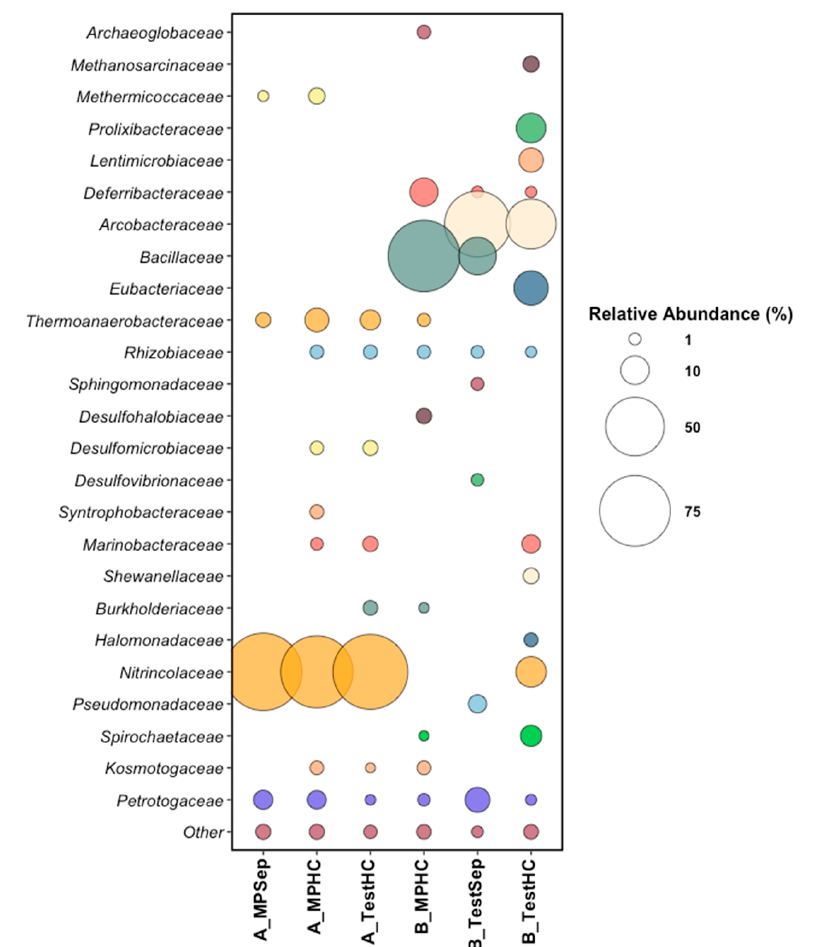
Figure 2. 16S rRNA gene sequencing data displayed by relative sequence abundance (%) for sampling locations on Platforms A and B. Only taxa above a 1% relative sequence abundance are displayed. The ‘other’ category includes taxa that are below a 1% relative read abundance. If no bubble appears next to a taxon, it indicates that that taxon does not appear above a 1% relative sequence abundance in the corresponding sample.